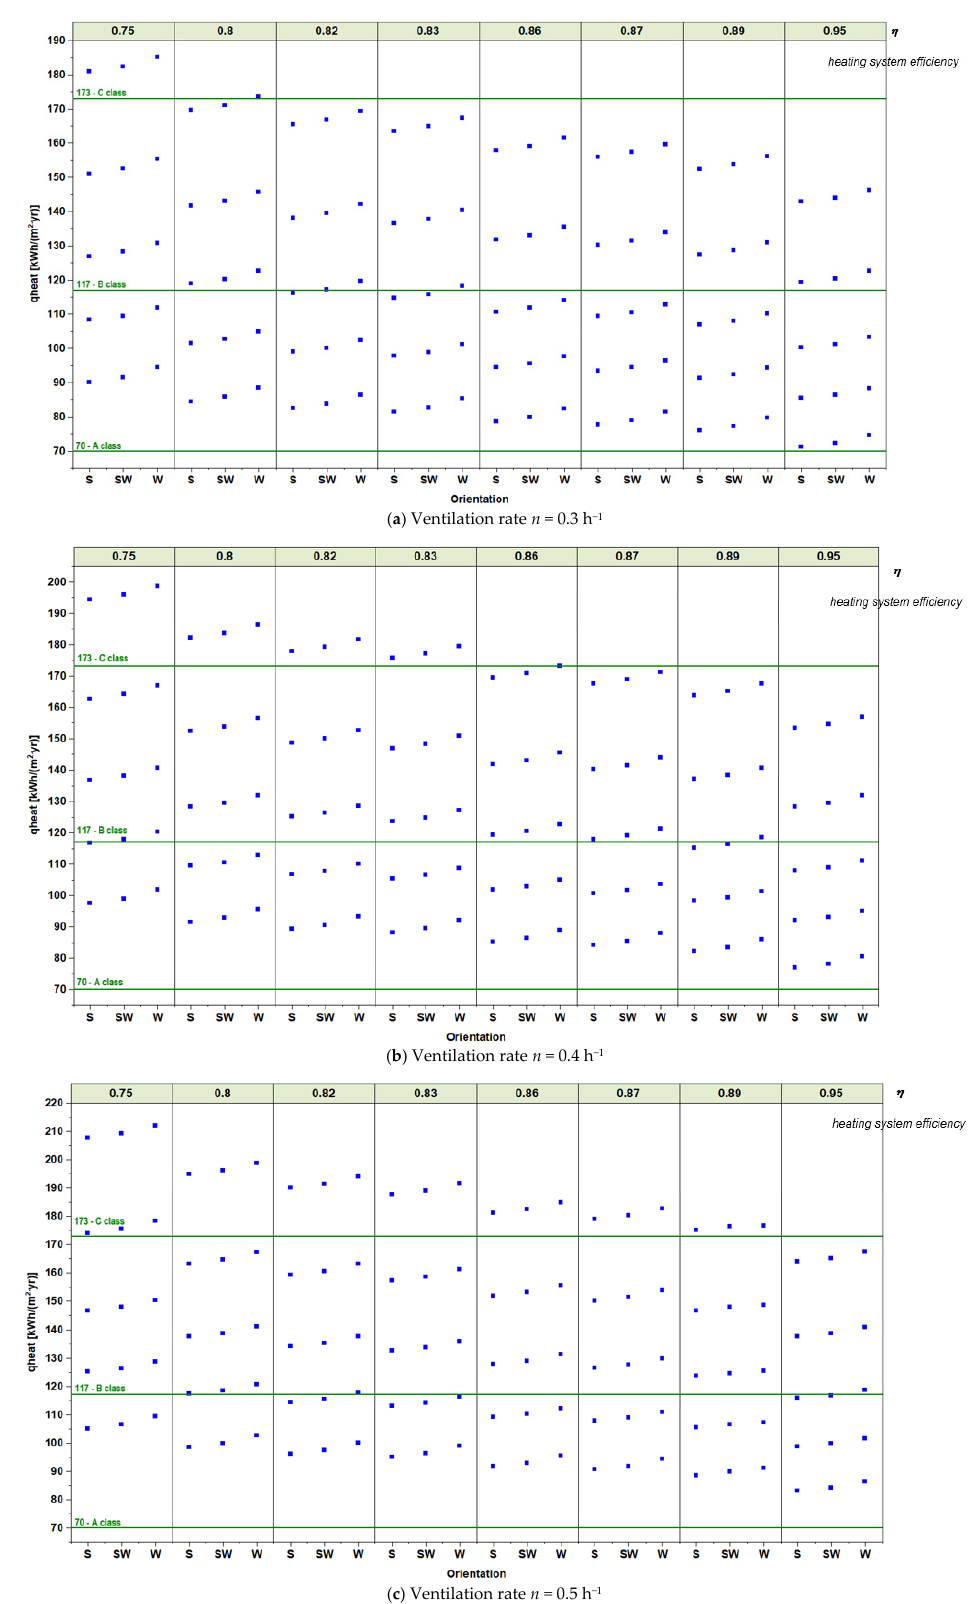
Figure 14. The energy consumption for heating for the case scenario ( a ) n = 0.3 h − 1 , ( b ) n = 0.4 h − 1 , ( c ) n = 0.5 h − 1 for the five climatic zones and for the heating system efficiency raging from η = 75% up to η = 95%. Table 8. Obtained minimum and maximum values for the heating energy consumption, q heat , and corresponding energy class for heating per climatic zone. Values